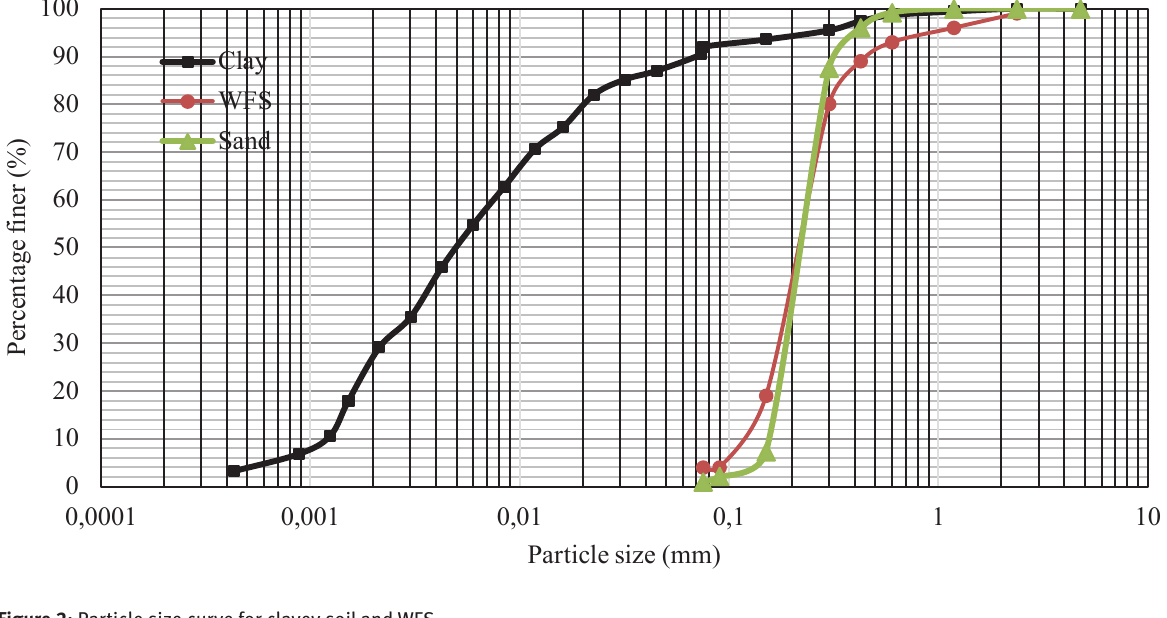
Figure 2: Particle size curve for clayey soil and WFS.